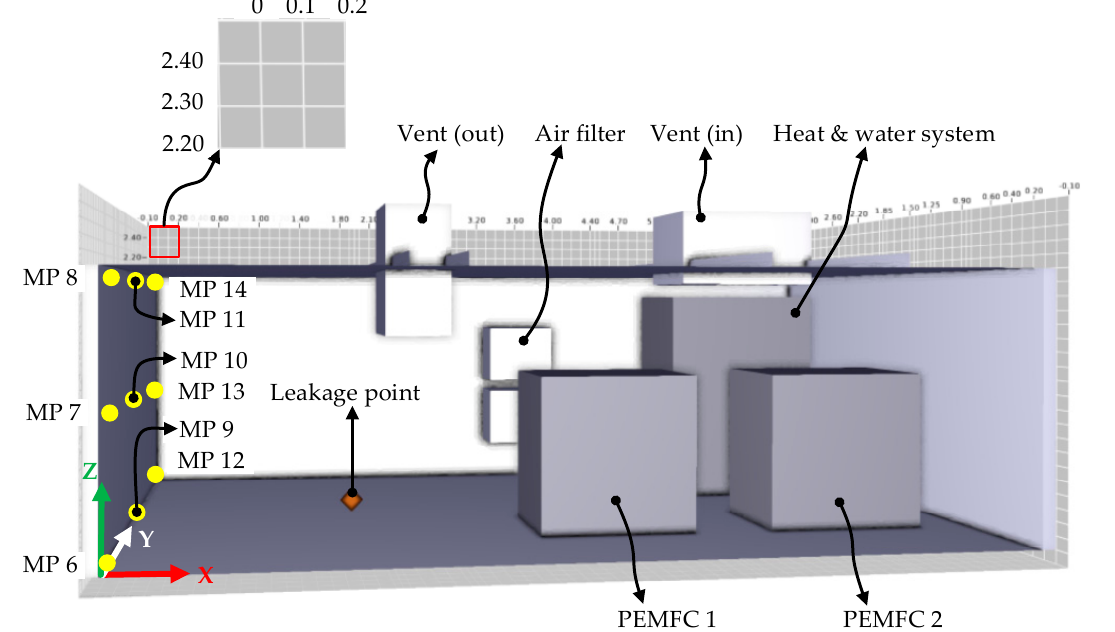
Figure 7. Three-dimensional view of the grid sizes, gas monitoring points on the YZ plane (X = 0.1 m), and internal equipment in the fuel cell room.